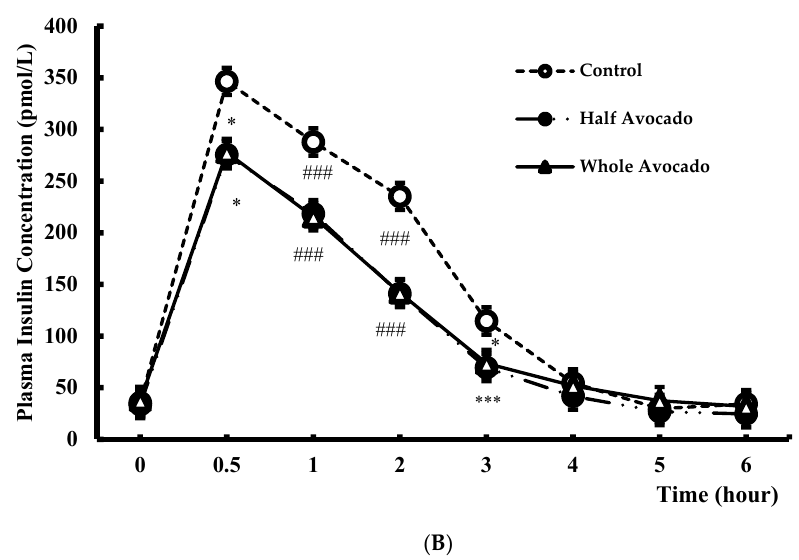
Figure 3. ( A ) Plasma glucose response over 6 hours after consuming test meal. The figure legend indicates test meal groups ( n = 31). Data were analyzed by PROC MIXED using SAS 9.4. Main effects of meal p = 0.07, time p < 0.0001, and meal by time p < 0.0001. Data are means ± SE, n = 31. * p < 0.05, *** p < 0.005, ### p < 0.0001 for the difference compared to Control; ( B ) Plasma Insulin response over 6 h after consuming test meal. The figure legend indicates test meal groups ( n = 31). Data were